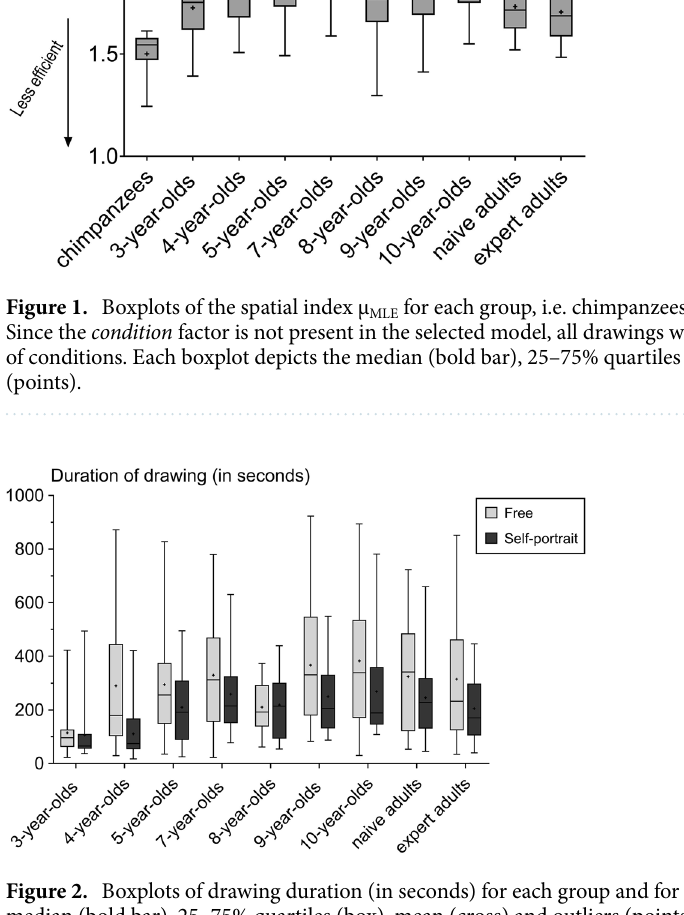
The use of colors. Number of colors used. The results of the model (Supplementary Table S3A) indicate that chimpanzees used fewer colors than humans (across all groups; GLM Poisson, p ≤ 0.001, t > 3.29, Fig. 3A). After model selection, the factors conditions and sex were retained to explain the number of colors used in humans. The number of colors used is higher under the free condition than under the self-portrait condition (p < 0.0001, t = 5.06, Fig. 3A, Supplementary Table S3B). Furthermore, there is a gender-related difference in the use of color. Women and girls used significantly more colors than men and boys (p < 0.001, t = 2.97). Number of color changes. Chimpanzees did not change the colors they used as much as the human participants did (GLM Negative binomial, p < 0.008, t > 3.34, Fig. 3B, Supplementary Table S4A). In humans, the number of color changes was higher in the free condition compared to the self-portrait condition (GLM Negative binomial, p < 0.0001, t = 4.45, Fig. 3B, Supplementary Table S4B). Furthermore, men and boys changed the colors they used significantly less often than women and girls in all groups (p = 0.002, t = − 3.11).